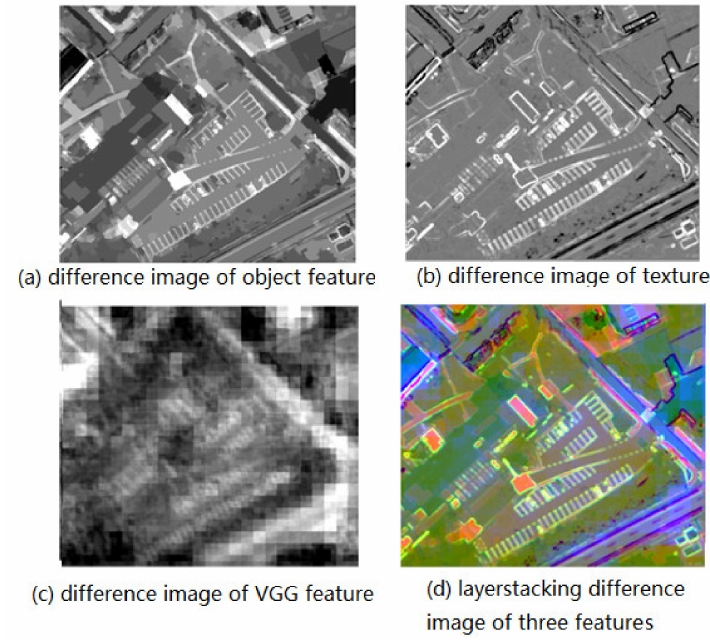
Figure 9. Di ff erence